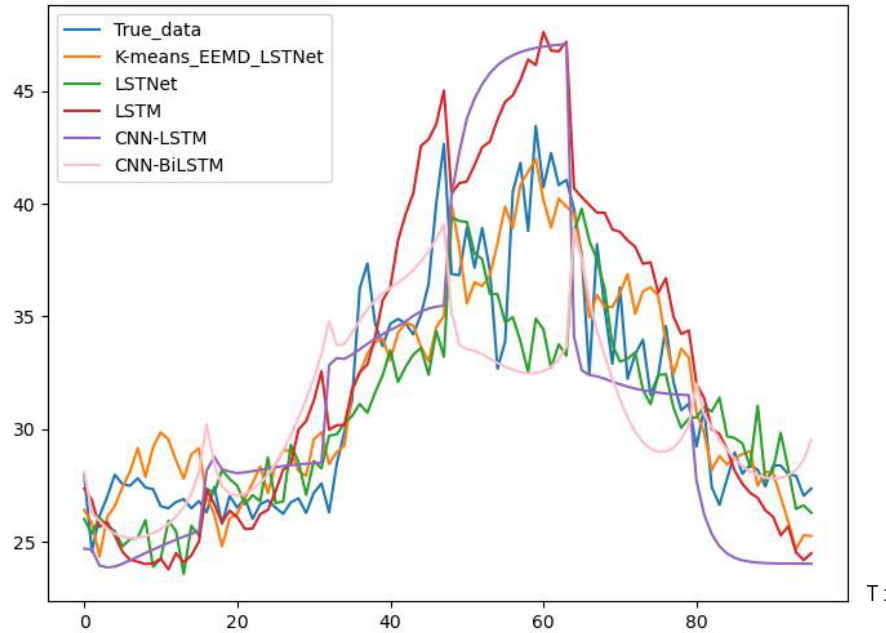
Figure 9. Comparison of predicted results for LSTM, CNN-LSTM, CNN-BiLSTM, LSTNet and K-means-EEMD-LSTNet load forecasting